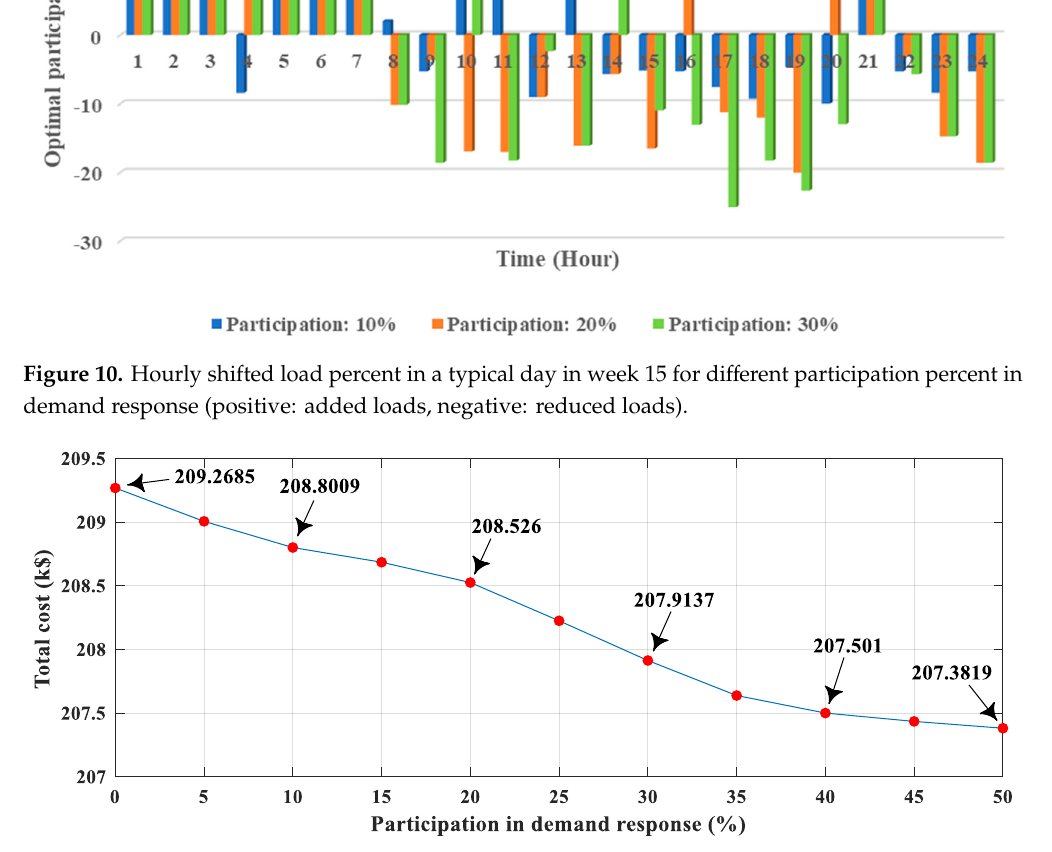
Figure 11. Decreasing trend of total cost of the system for typical day in week 15 respect to demand response. Table 9. The units’ cost for di ff erent participation percent in demand response for typical days in the weeks 31, 35, and